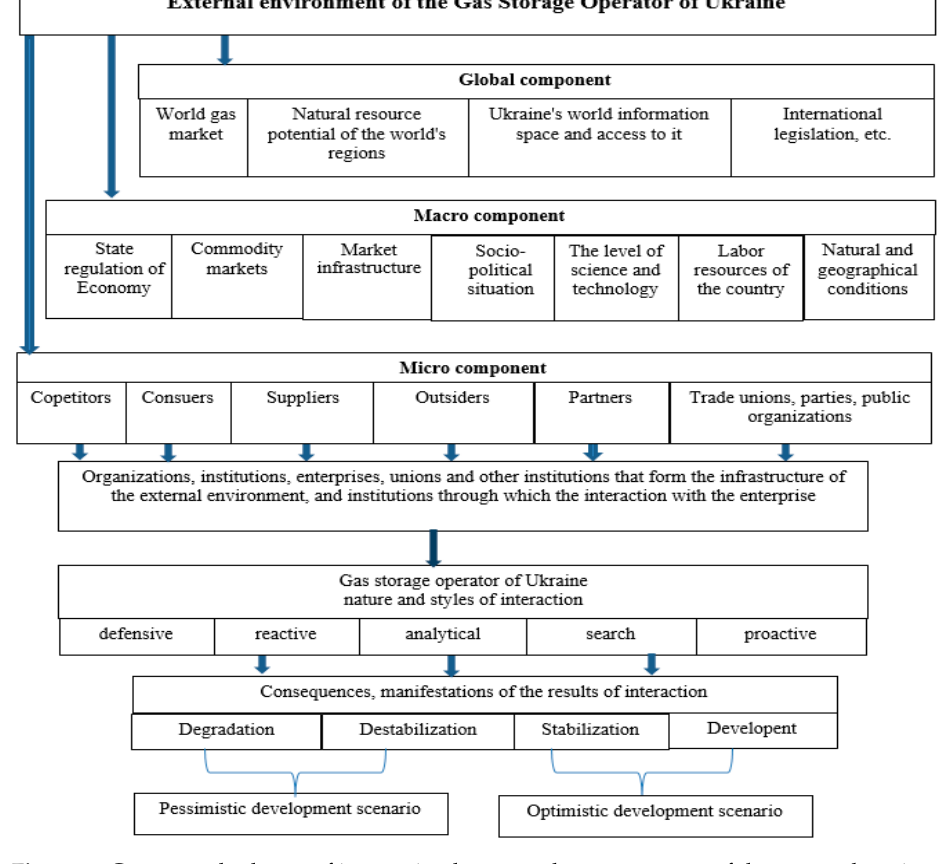
Figure 5. Conceptual scheme of interaction between the components of the external environment and the Gas Storage Operator of Ukraine. Source: improved based on [48,49]. and the Gas Storage Operator of Ukraine. Source: improved based on